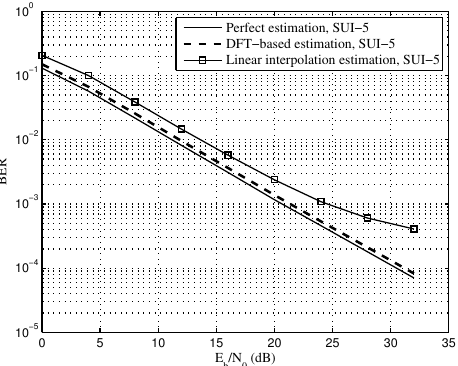
Figure 13. BER of the proposed DFT-based and linear interpolation methods under the SUI-5 channel, time synchronization error L e = 0.9 µ